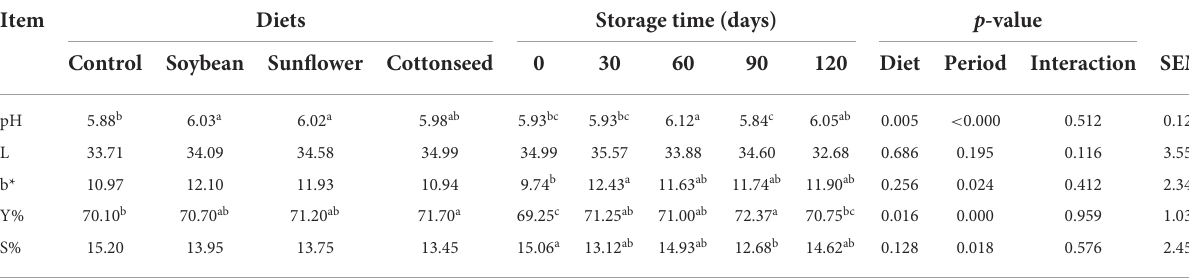
TABLE 3 Instrumental characteristics of beef burgers subjected to different diets and storage period. Item Diets Storage time (days) p -value Control Soybean Sunflower Cottonseed